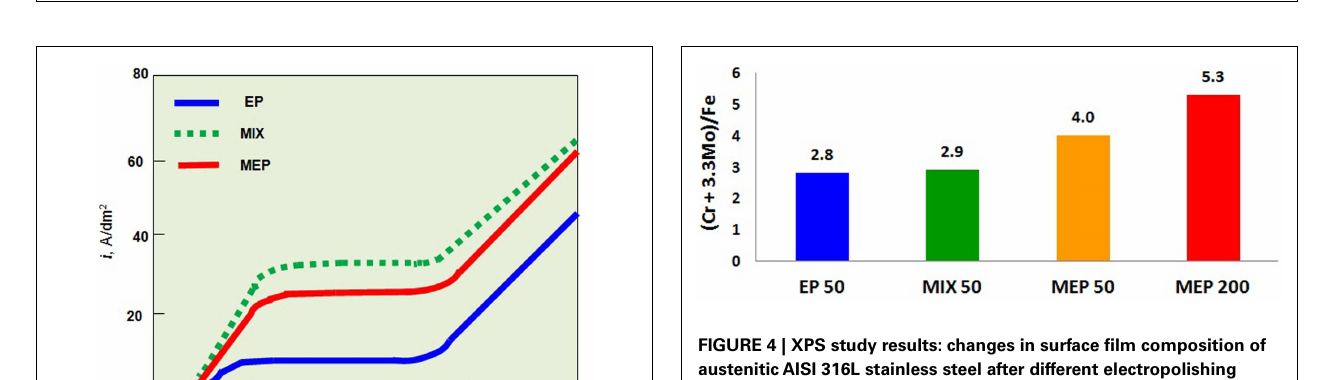
FIGURE 2 | Set-up used for electrochemical polishing in the magnetic field MEP: (A) scheme of connections, (B) photo (a, thermometer; b, anode; c, cathode; d, electrochemical cell; e, heater; f, neodymium magnet) .